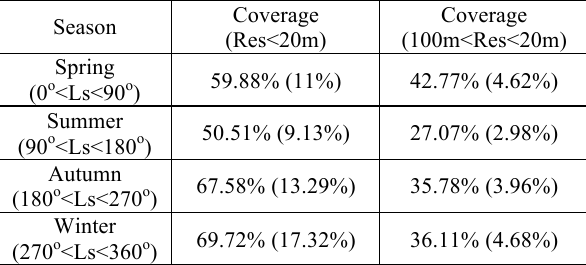
Table 4: Martian surface global coverage statistics for